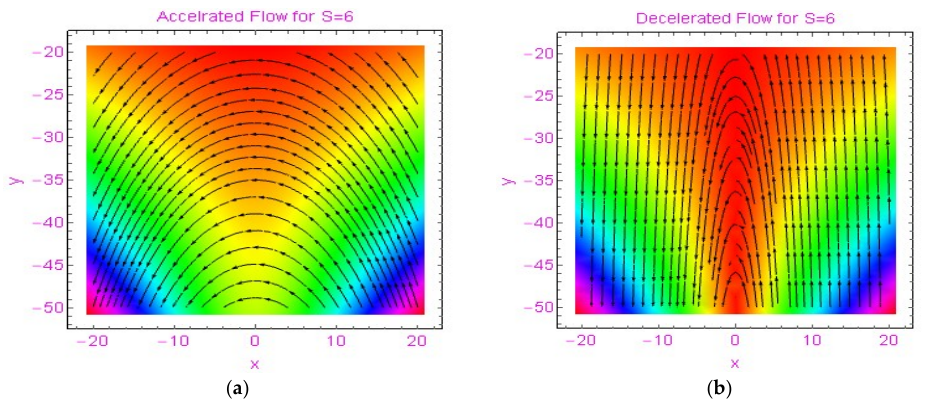
Figure 6. Streamlines behavior for ( a ) accelerated and ( b ) decelerated flow situations when S = 6.